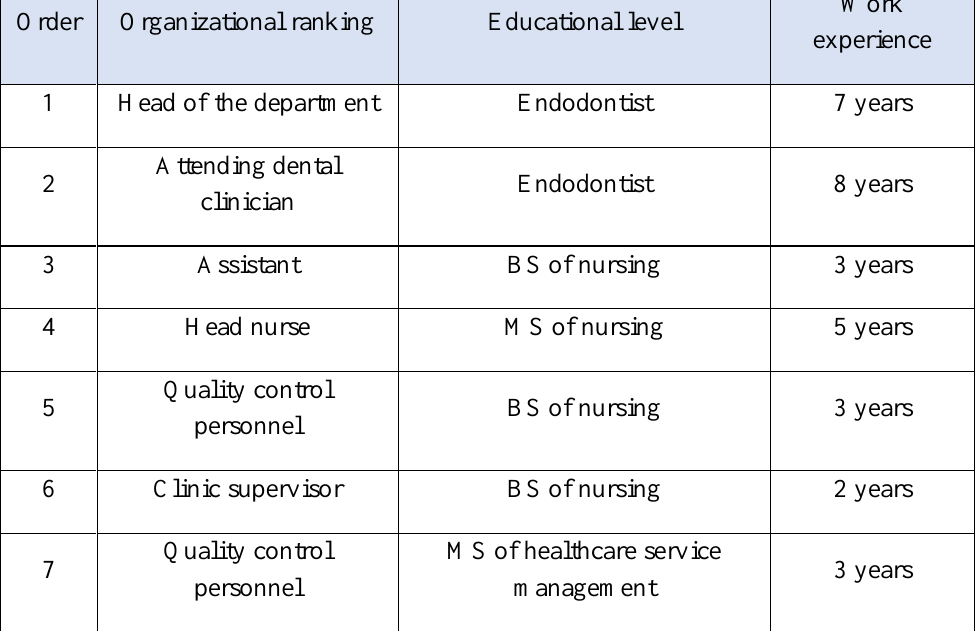
Work experience